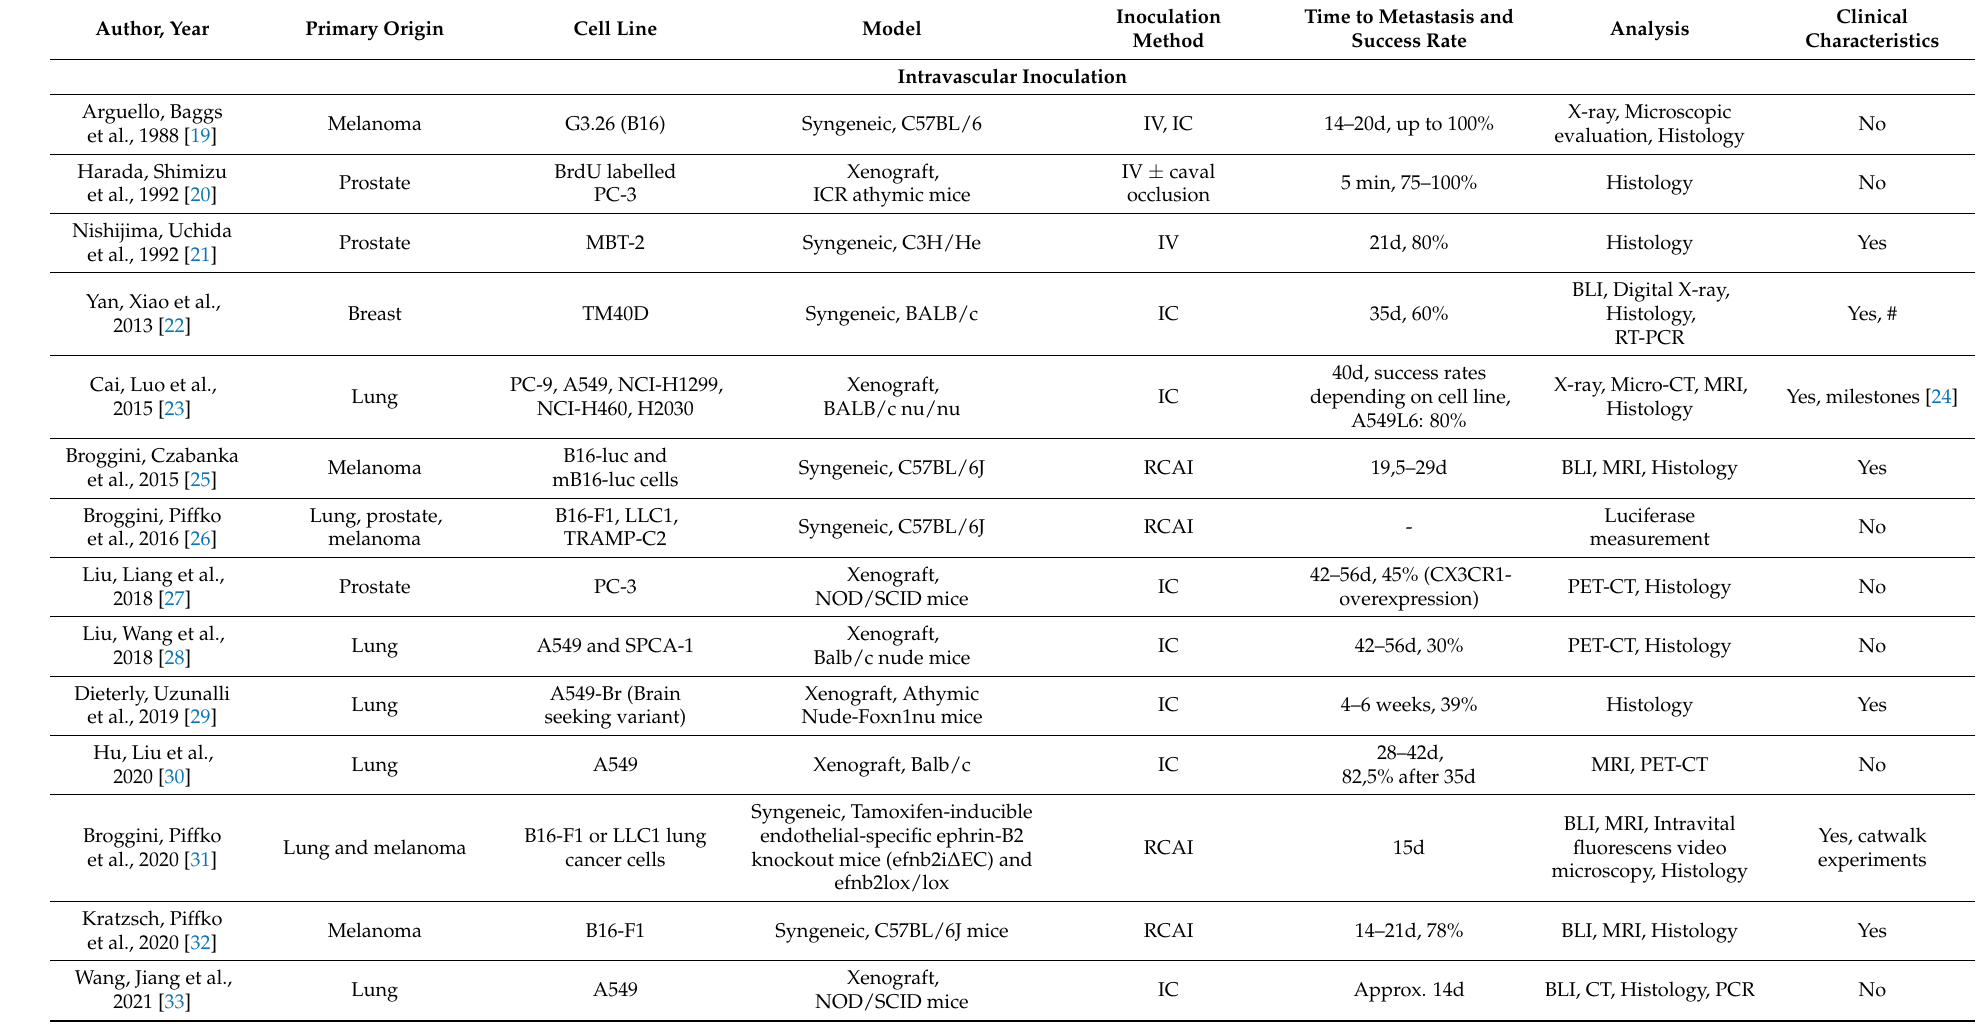
Table 1. Characteristics of currently used mouse models in the experimental research of spinal